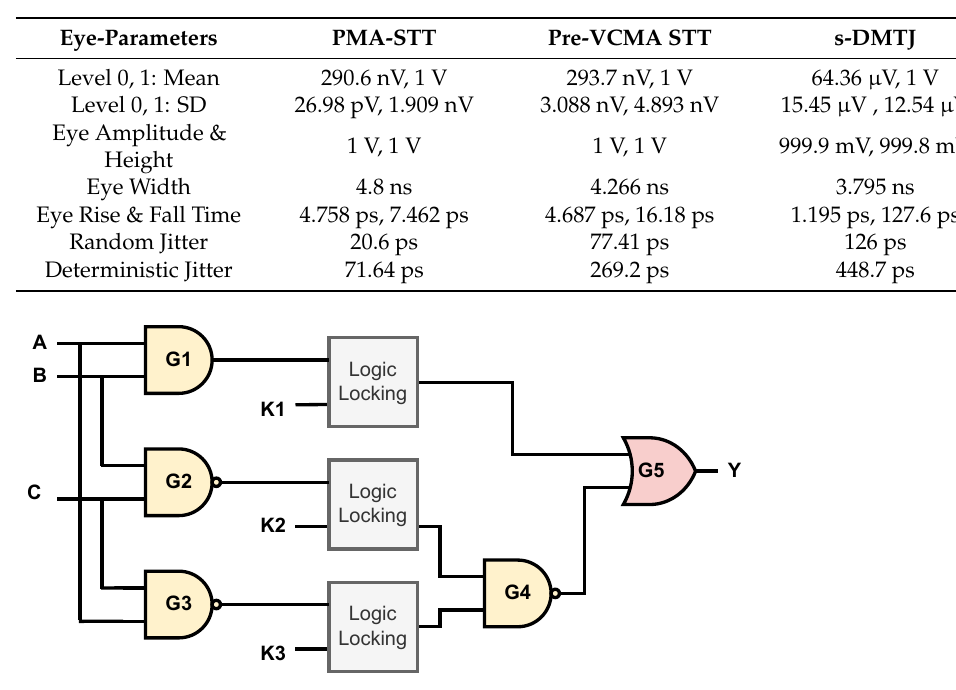
Figure 6. Test circuit where some of the CMOS AND logic gates are replaced by the LL block. Table 3. Truth table for all possible outcomes for s-PMA DMTJ based LL block implementing Y = AB + BC + CA.